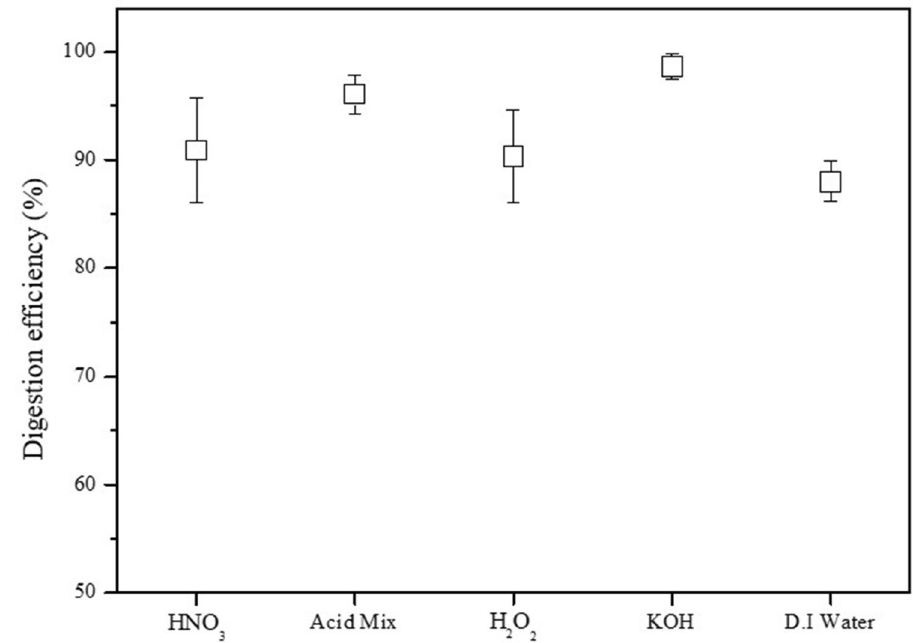
Figure 1. Digestion efficiency using different